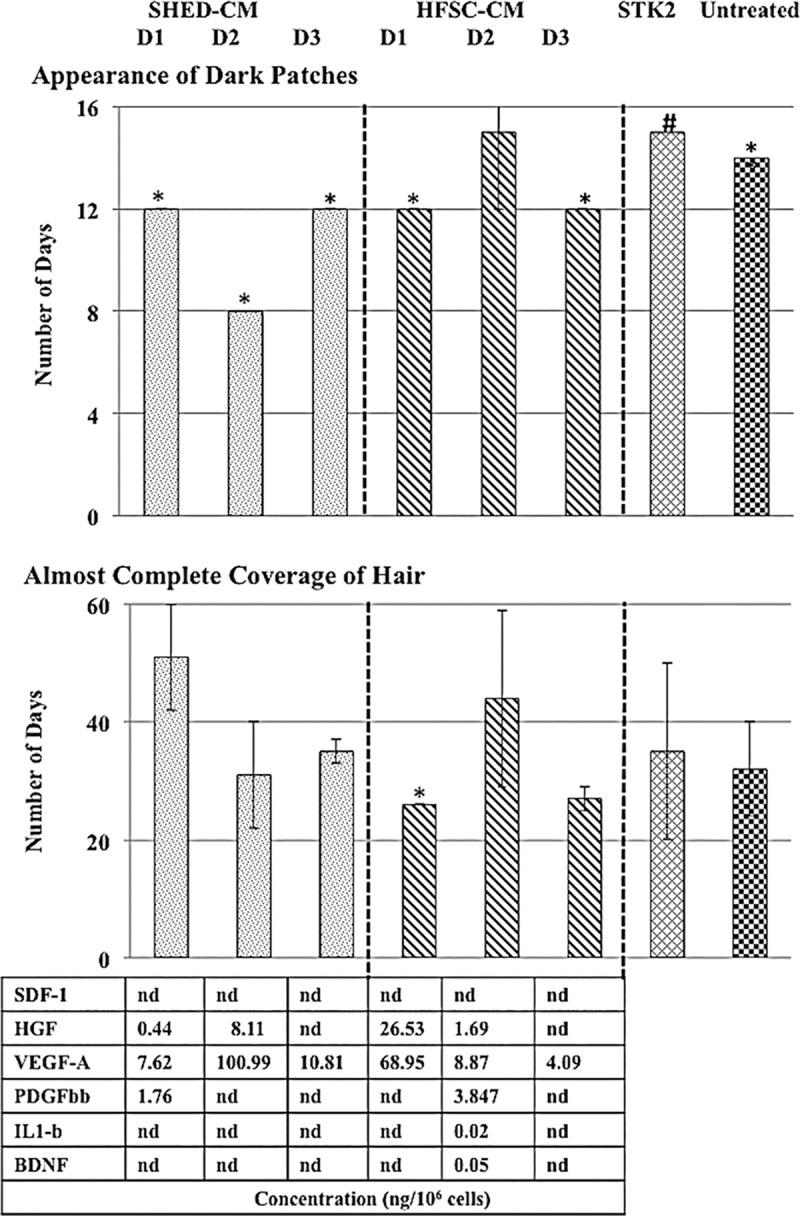
Number of days taken for the appearance of dark patches and almost complete hair coverage with the corresponding paracrine factor profiling of the CM prepared in STK2-serum free media.The number of days taken for the appearance of dark patches and almost complete hair coverage in C3H/HeN mice when treated with three subcutaneous injections of 100μl of SHED-CM (n = 3), HFSC-CM (n = 3) and STK2 (n = 3) at three day intervals and the untreated C3H/HeN mice (n = 2). The corresponding cytokine profiling for the donor from which the CM was prepared in also indicated. * Standard error = 0, # Standard error = 1 and D = Donor.